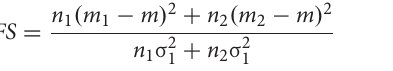
ROI of AAL-1024 atlas has approximately identical size (Wu et al.,